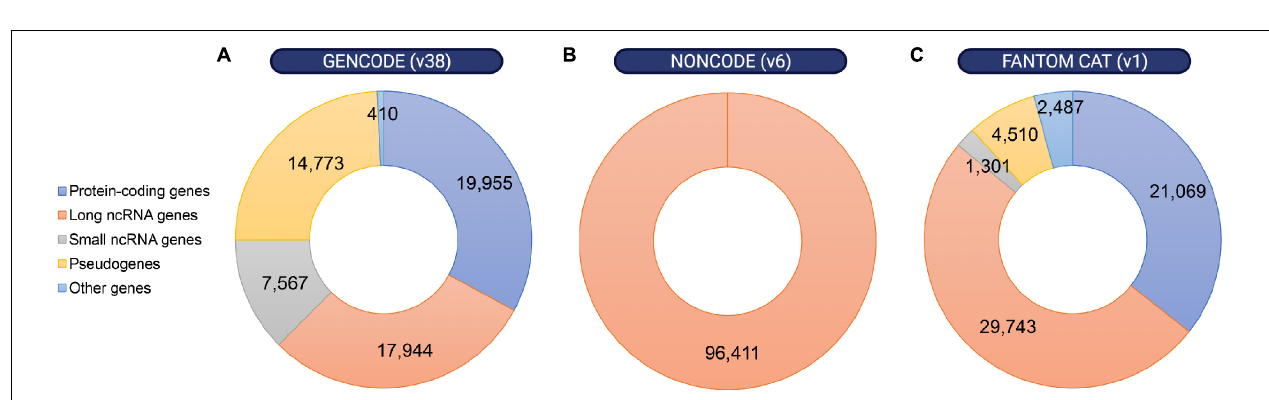
FIGURE 1 | Classification of lncRNAs based on their genomic location. (A) Intergenic RNAs are located between two protein-coding genes, (B) intronic lncRNAs are transcribed within an intronic region of a protein-coding gene, (C) bidirectional lncRNAs are located on the opposite strand of a protein-coding gene whose transcription initiates less than 1,000 base pairs away, (D) sense lncRNAs are transcribed from and overlap with the sense strand of a protein-coding gene, (E) antisense lncRNAs originate from the antisense strand of a protein coding-gene, and (F) enhancer RNAs derive from enhancer regions and play a role in gene transcription activation. Protein-coding genes/exons shown in gray; LncRNA genes/exons shown in blue.